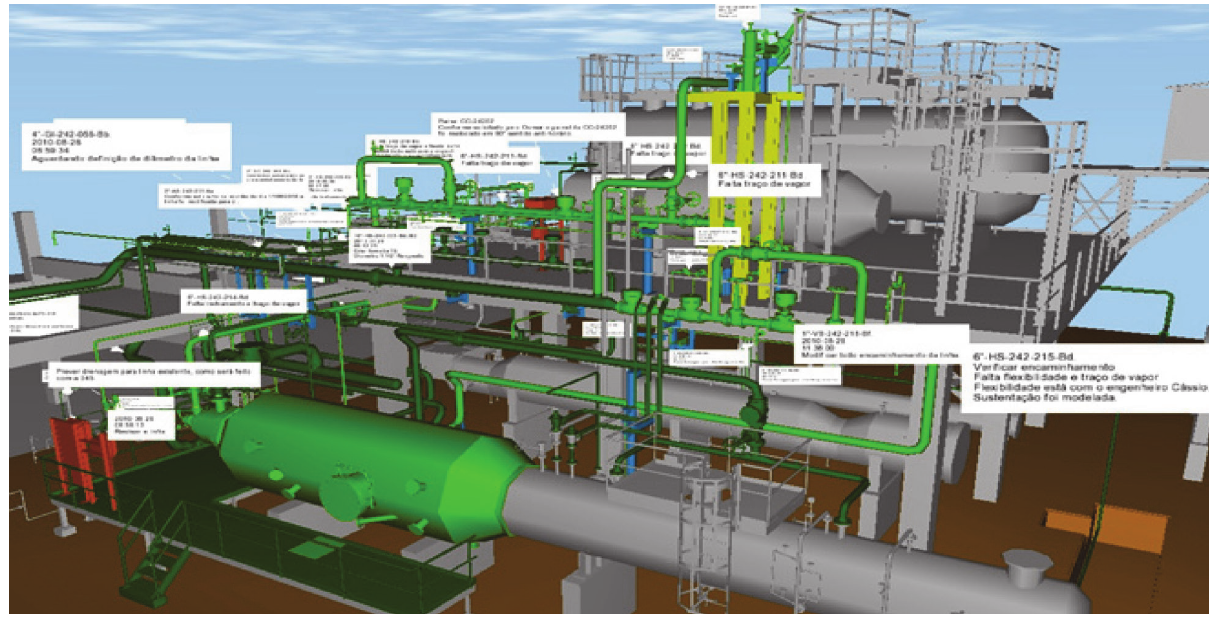
Figure 4. Collaboration between project and construction with nD